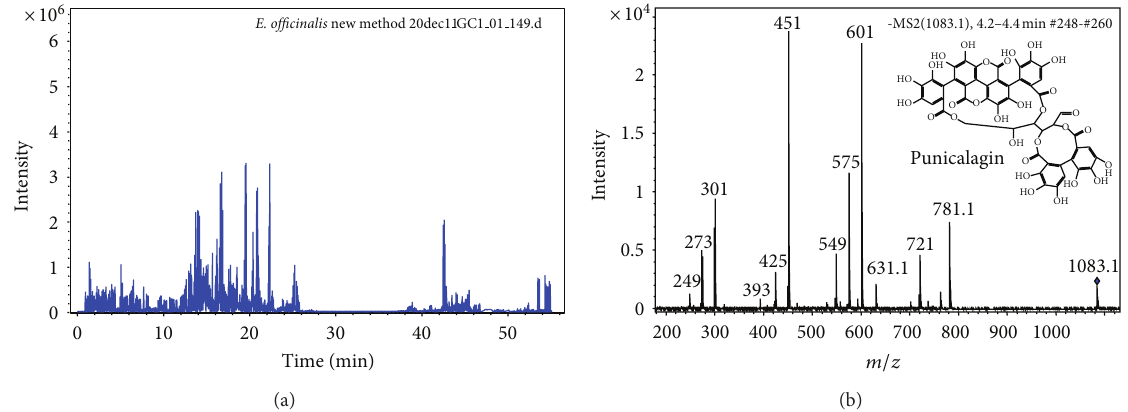
Figure 3: Chromatograms obtained from reversed-phase LC-ESI-QTOF-MS analysis of Phyllanthus emblica extract. (a) Total ion chromatogram (QTOF MS); (b) corresponding to m/z for the most intense peaks of MS/MS spectrum pattern of punicalagin.